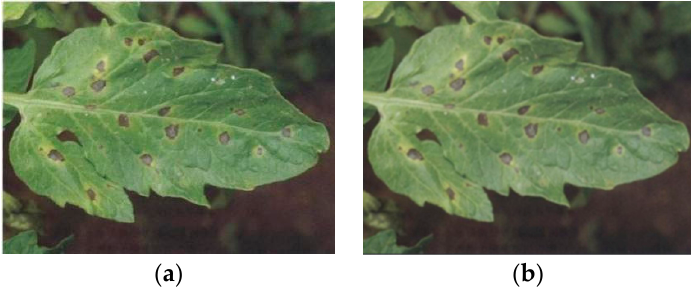
Figure 8. Original image and pre-processed image of tomato leaf mildew. ( a )The Original image of tomato leaf mildew, ( b ) The pre-processed image of tomato leaf mildew.